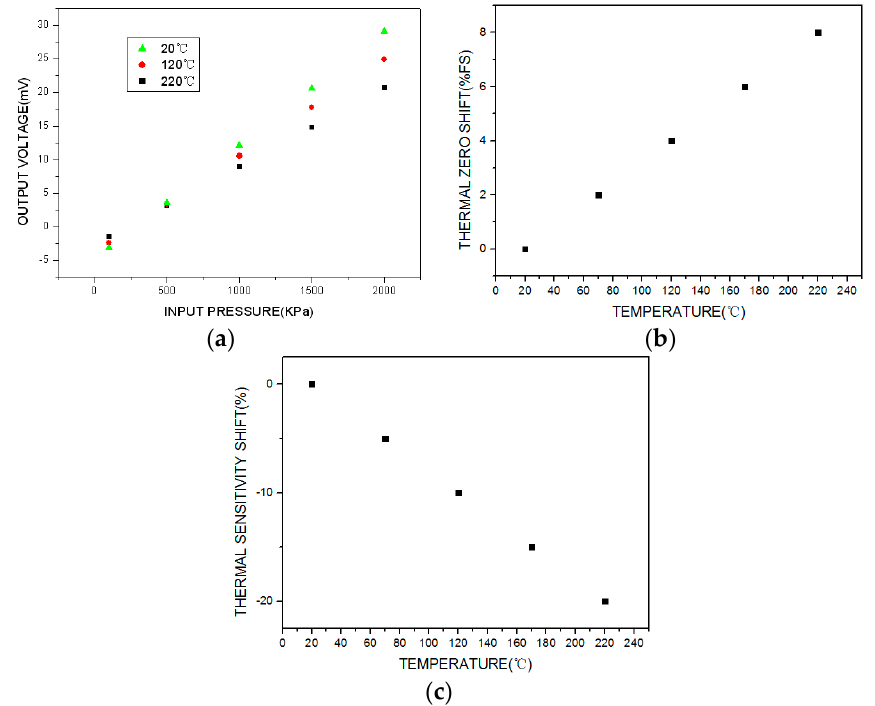
Figure 9. Test results for the compensated high-temperature pressure sensor with the traditional temperature compensation model and experiential arithmetic: ( a ) output voltage calibration curve in the temperature and pressure environment; ( b ) thermal zero shift; ( c ) thermal sensitivity shift. Table 2. Test results for bridge arm resistors under different environmental conditions.